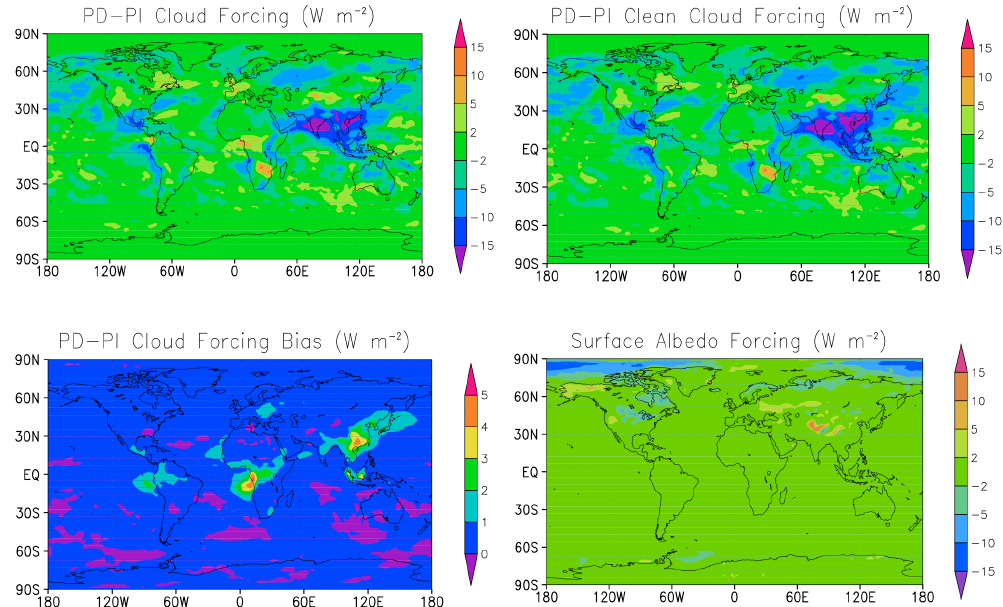
Fig. 1. Present-day – preindustrial difference in five-year annual mean top-of-atmosphere shortwave cloud radiative forcing (top left), clean-sky shortwave cloud radiative forcing (top right), the difference (bottom left) and the surface albedo forcing (bottom right) simulated by CAM5.1.